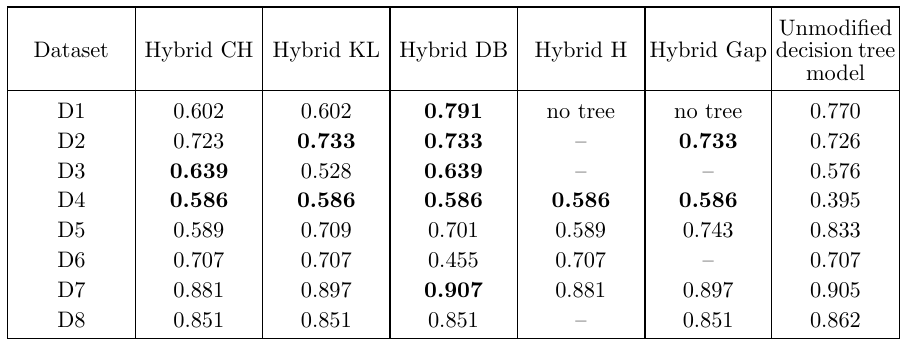
Values of accuracy